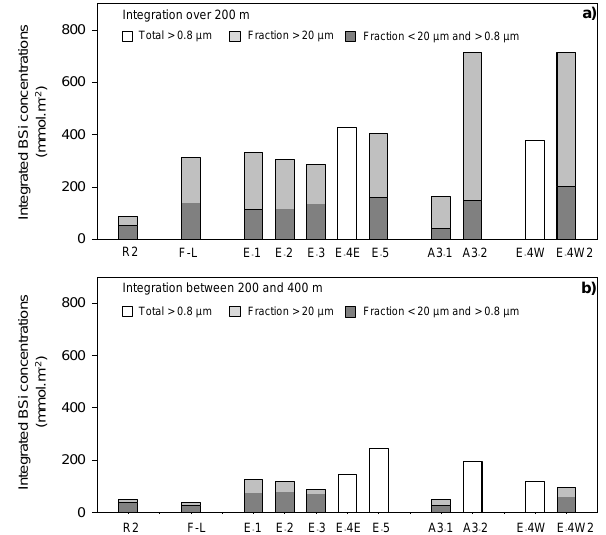
Figure 12. Figure 12. Temporal evolution of BSi concentrations within 200m (a) (except for A3-2 where data were integrated down to 160m) and between 200 and 400 (b) for three size fractions (>0.8µm, between 0.8 and 20µm and >20µm) at the complex system of recirculation, at the plateau reference station A3, at station E-4W (stations legend as in Fig. 7). The station F–L and the HNLC reference station R2 are presented for comparison. At some stations, size-fractionation was not performed because of logistical problems